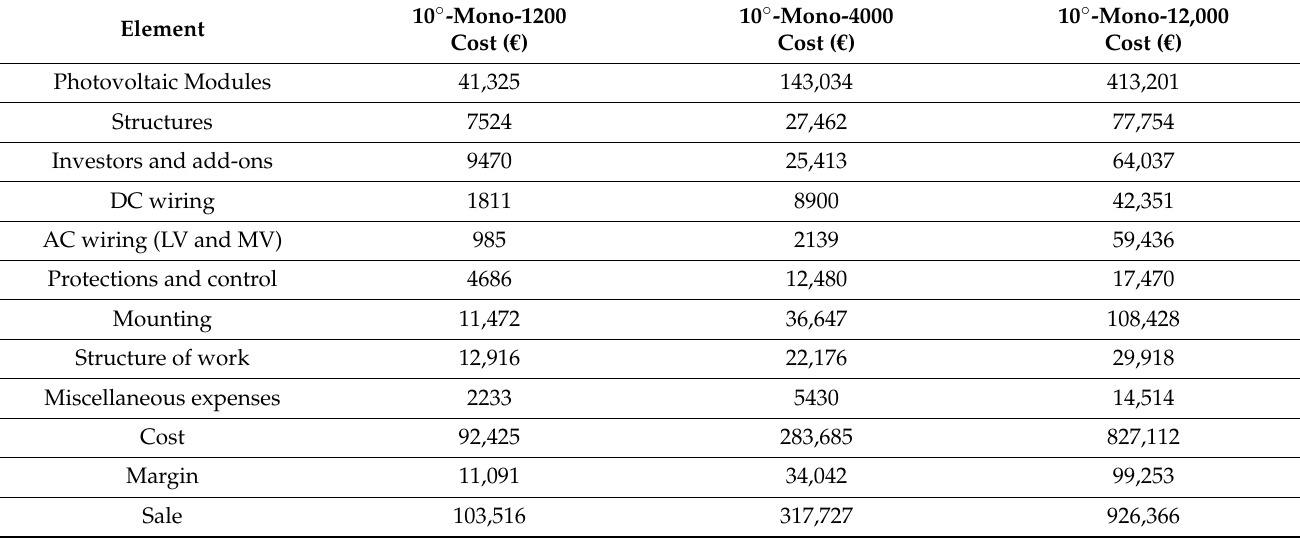
Table 2. Cost decomposition grouped by items for the three base cases.